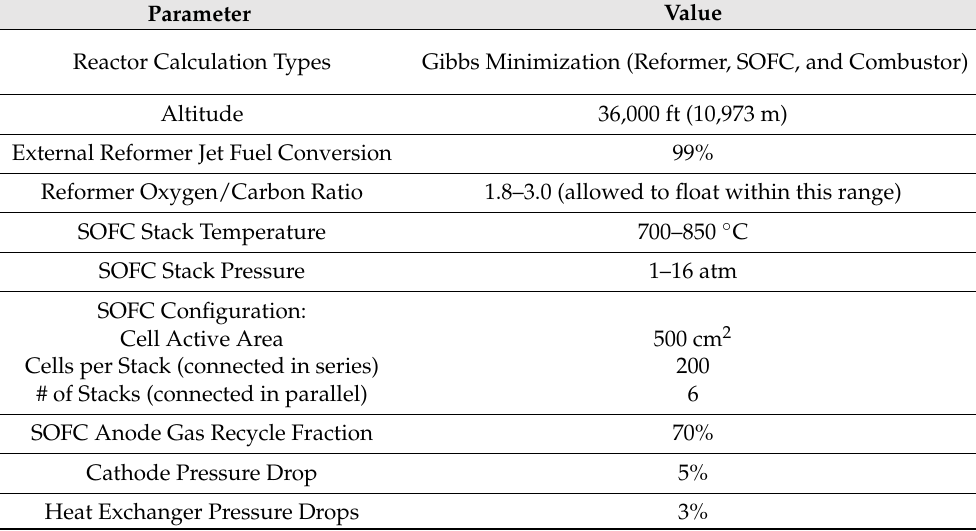
Table 2. Summary of top-level specifications for this model of aviation hybrid SOFC